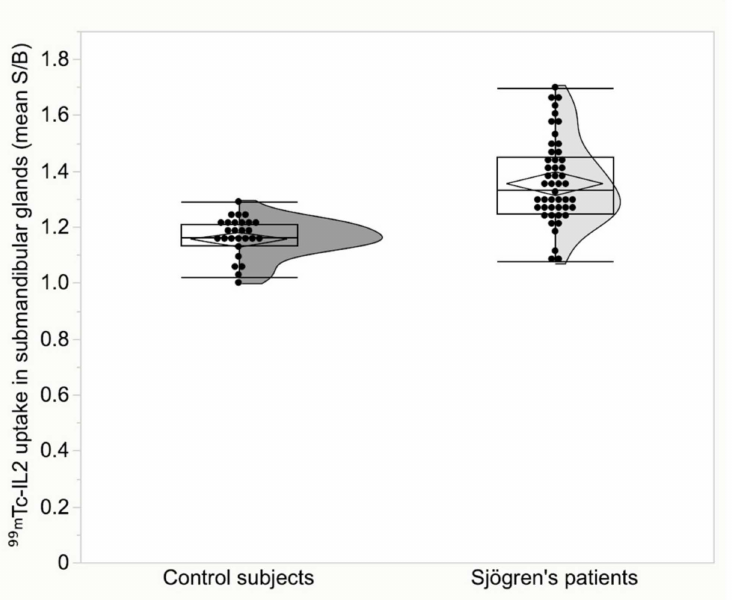
Figure 4. Submandibular gland uptake of 99m Tc-IL2 in patients with Sjögren disease compared to control subjects ( p < 0.001).